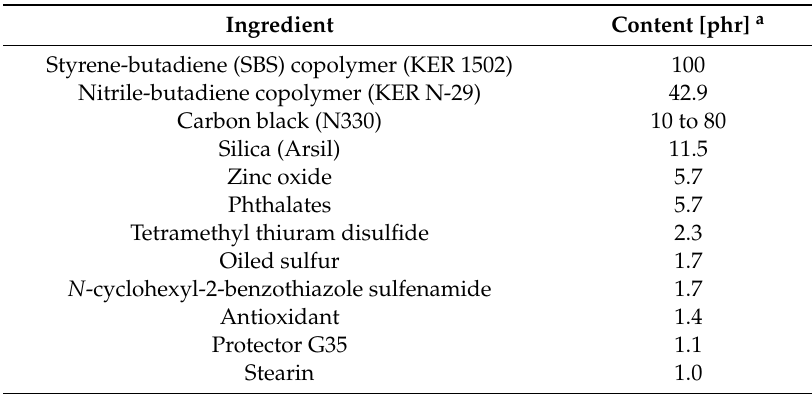
Table 1. The compound composition of the SBS